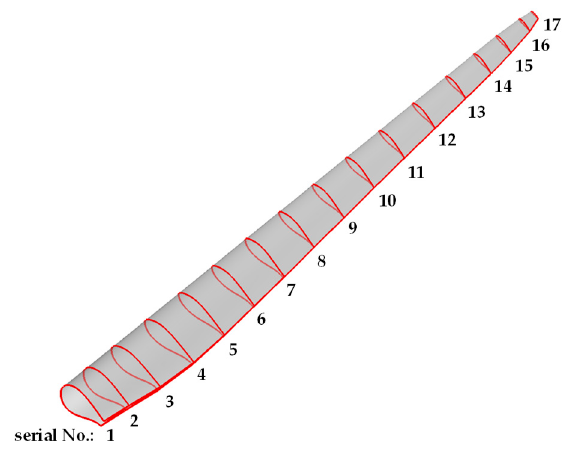
Figure 13. Serial number of the control section.